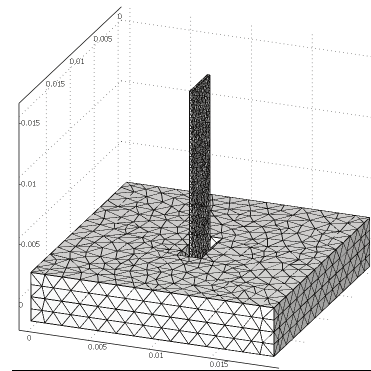
Figure 5. Finite element analysis was performed using COMSOL. Mesh was created with 2907 tetrahedral, 2090 boundary triangular elements, 1048 mesh points and 18,141 degrees of freedom. Finer mesh sizes were tested but no notable difference was seen in the results.